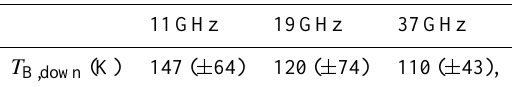
Table 13. Average optimized T B,down and standard deviation (in parentheses)